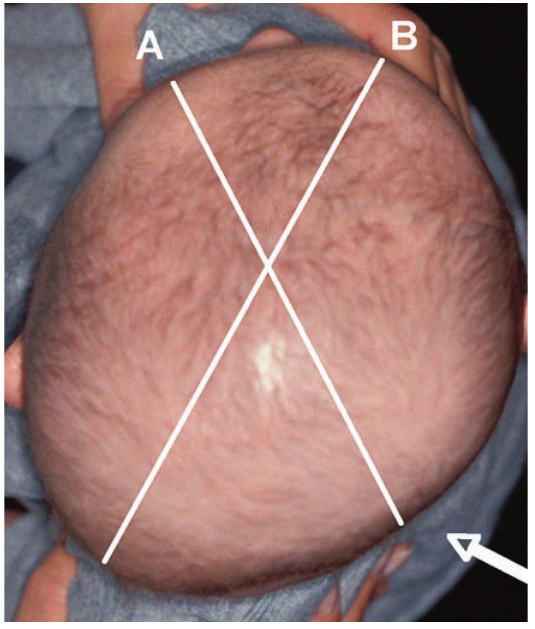
Figure 1 Right posterior positional plagiocephaly. Vertex view of the head. Right occipital flattening (arrow). Short (A) and long (B) fronto-occipital diagonals. helmet was worn progressively during the first week of treatment up to 21 hours a day. Every 2–3 weeks, the chil- dren were followed up in the Ergotherapy Service for ad- justment of the orthoses where necessary. In addition, the patients were reevaluated at the end of the treatment by the senior authors. At every examination anthropometric measurements were repeated. Data are presented as the mean ± SD. Statistical comparisons were performed by the Student paired t test analysis. Significant differences were reported when the p value was